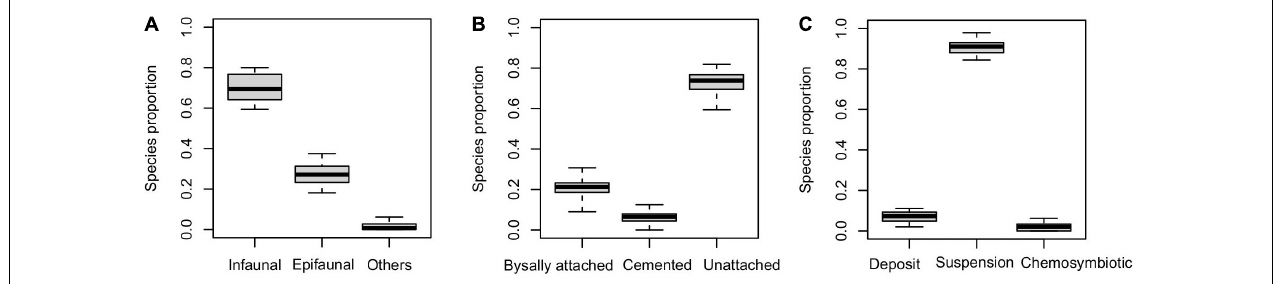
FIGURE 3 | Relative proportion of various ecological groups classified based on (A) substrate relationship, (B) attachment type, and (C) feeding type. The boxes are defined by 25th and 75th quantiles. The thick line represents median value within the